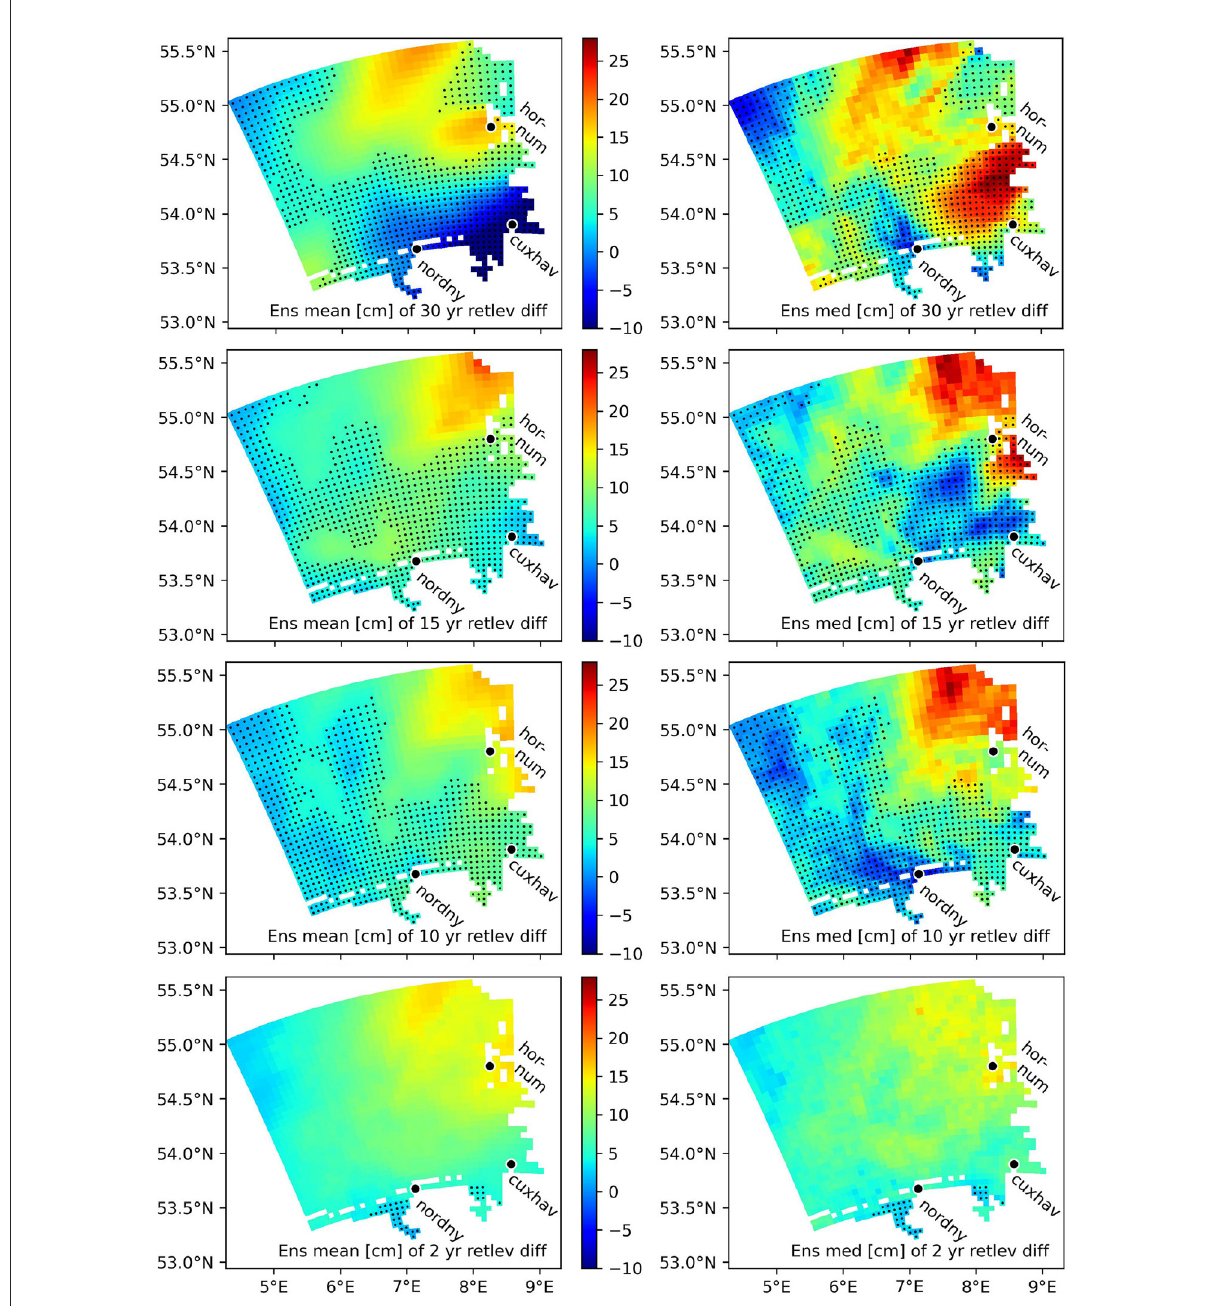
FIGURE4 Ensemble mean (left) and median (right) of the rcp85-hist differences of 30-, 15-, 10-, 2-year return levels ( top to bottom ) in the German Bight. Statistically insignificant areas ( p > 0.05) are dotted. Units correspond to a trend in